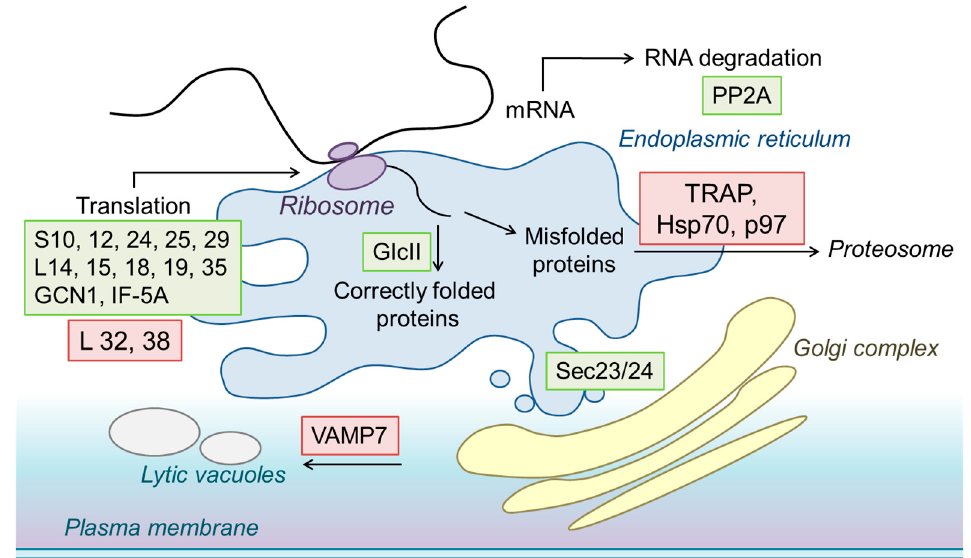
Figure 12. The pathways of protein synthesis and transport activated by CsRALF34 overexpression (based on the KEGG signal pathway database). Green, upregulated; red, downregulated proteins. PP2A, serine/threonine-protein phosphatase 2A; S10, 12, 24, 25, 29, 32, and 38, proteins of the small ribosomal subunit; L14, 15, 18, 19, and 35, proteins of the large ribosomal subunit; GlcII, mannosyl-oligosaccharide alpha-1,3-glucosidase; TRAP, translocon-associated protein subunit alpha; Hsp70, heat shock 70 kDa protein; p97, transitional endoplasmic reticulum ATPase; VAMP7, vesicle-associated membrane protein 7; Sec23/24, protein transporter from ER to Golgi.